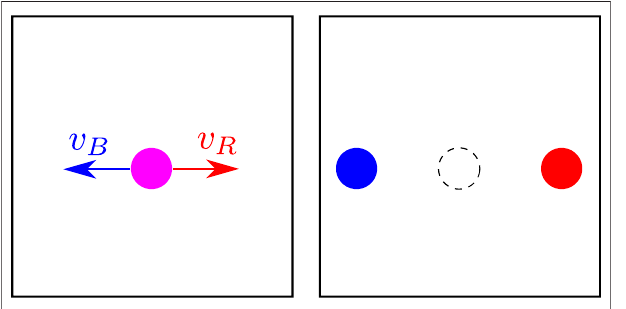
FIGURE 2 | Tracking of different color components in a synthetic example. In this case, each color component is associated to a speci fi c velocity fi eld.